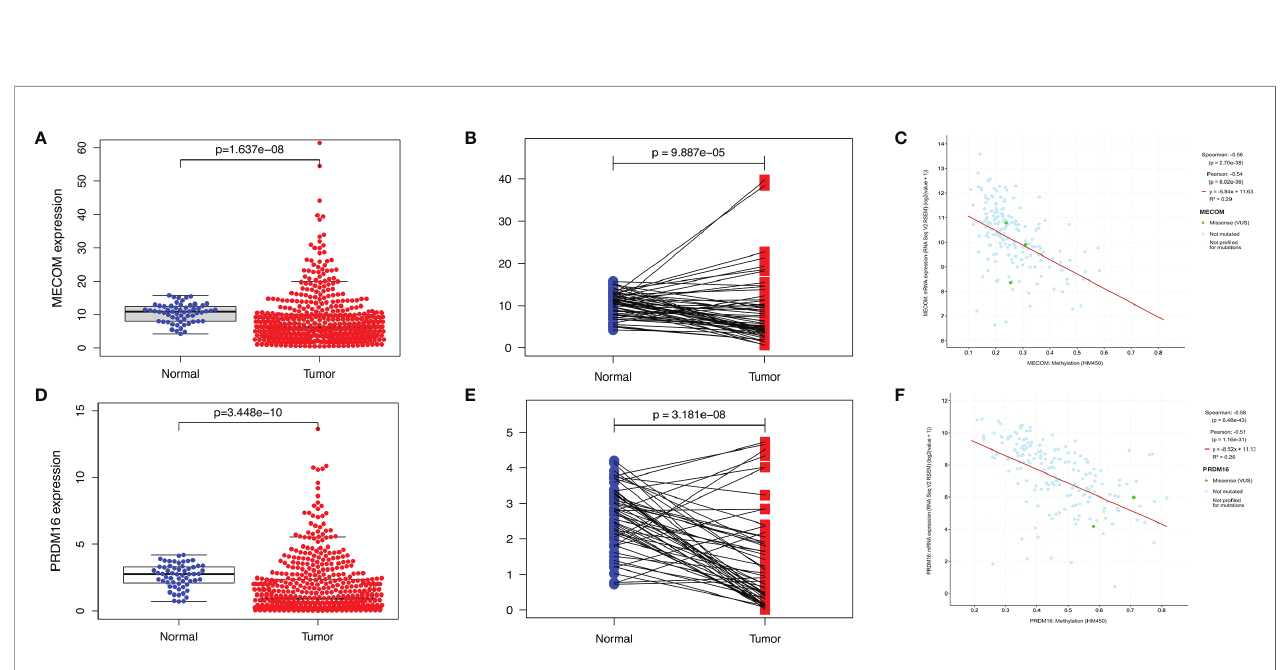
FIGURE 1 | Expression of MECOM and PRDM16 in various tumors. (A) Expression of MECOM and PRDM16 in various tumors in the Oncomine database. Note: red and blue represent upregulation and downregulation of the target gene, respectively. (B, C) Expression of MECOM (B) and PRDM16 (C) in various tumors in the TIMER database. * p < 0.05; ** p < 0.01; *** p < 0.001. MECOM, MDS1 and EVI1 complex locus, also called PRDM3; PRDM16, PR domain containing 16, also called